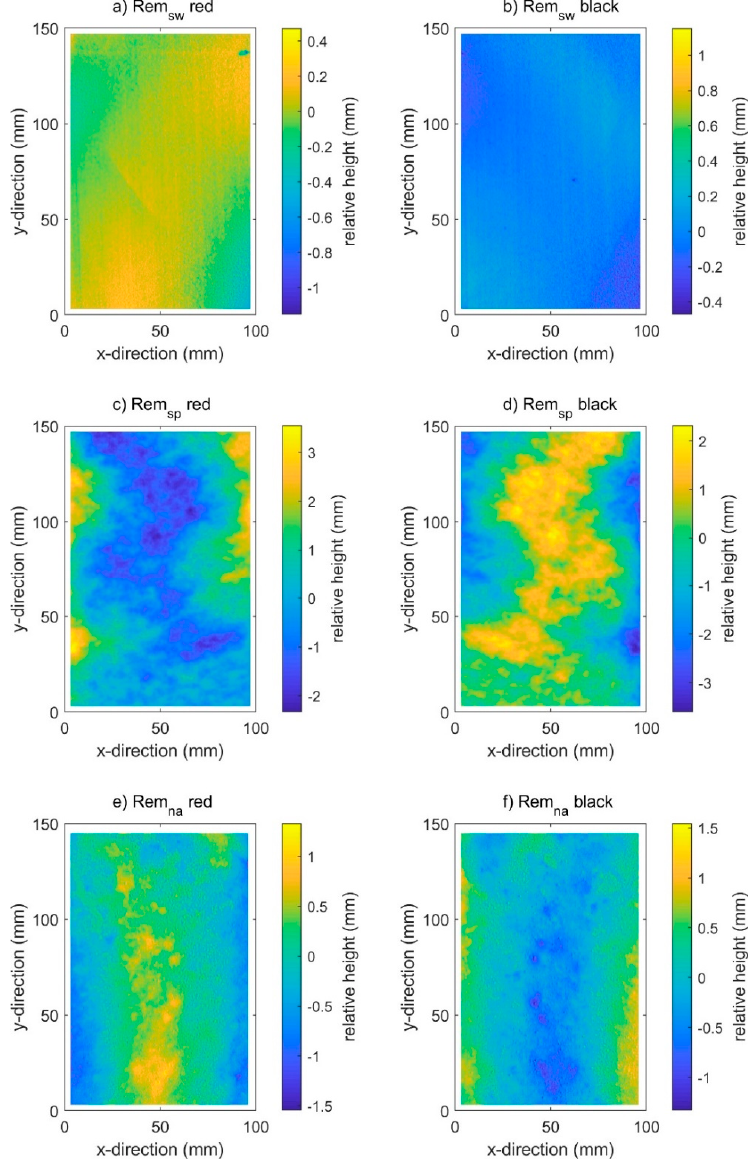
Figure 9. Relative height distribution of the specimen halves as used for the calculations. ( a ) red and ( b ) black half of the sawed specimen; ( c ) red and ( d ) black half of the split specimen; ( e ) red and ( f ) black half of the natural fractured